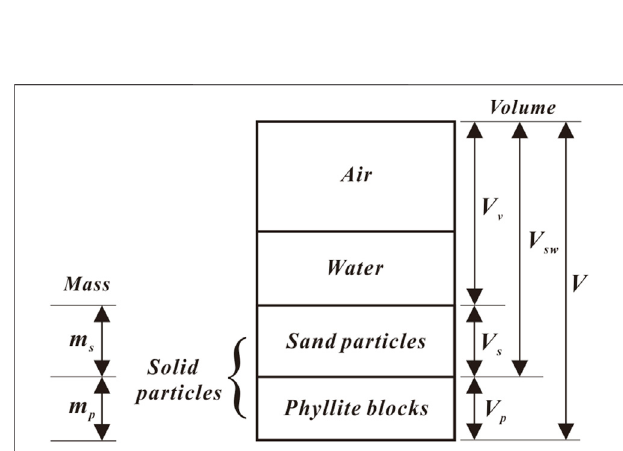
FIGURE 5 | Three-phase diagram of phyllite